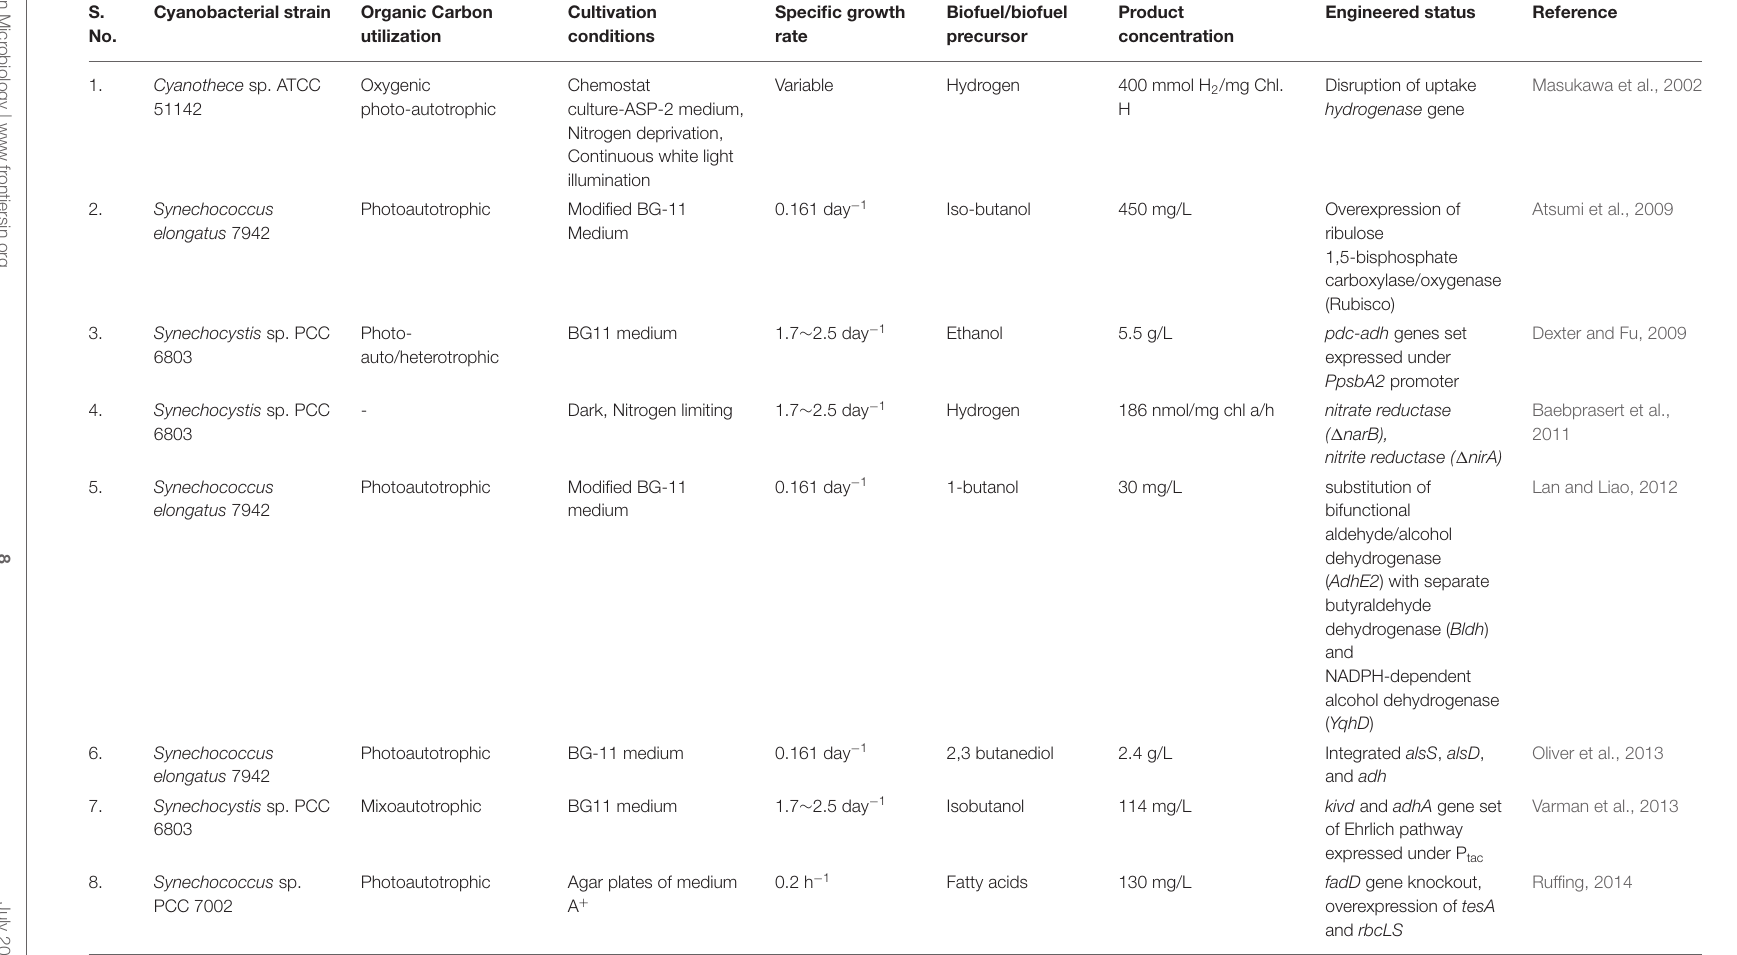
TABLE 1 | Different cyanobacterial strains genetically engineered for biofuel production. S.